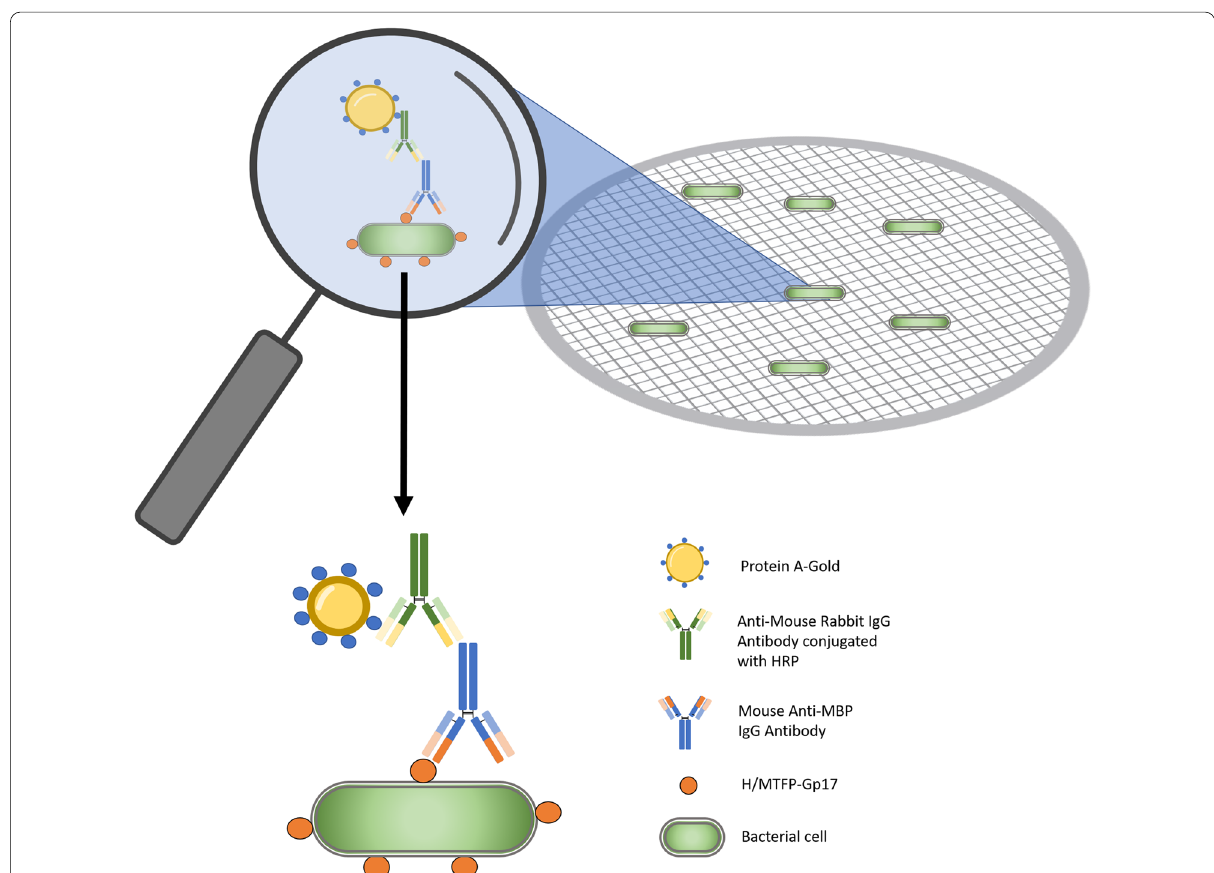
Fig. 4 Sandwich‑type preparation method based on immunogold labelling to visualize by TEM the interaction of H/MTFP‑Gp17 with bacterial cell